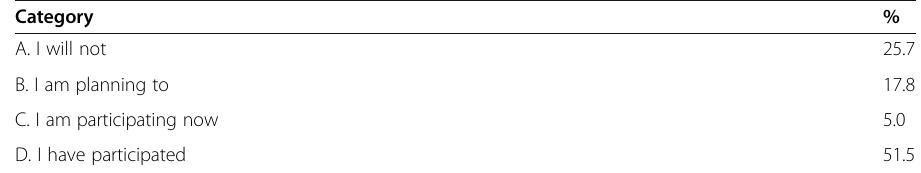
Table 8 Will you participate in private IELTS training agencies?